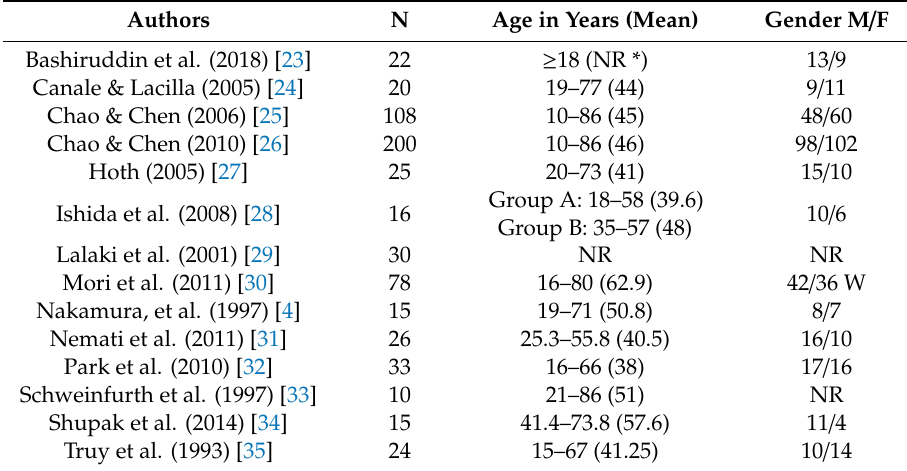
Table 2. Patient